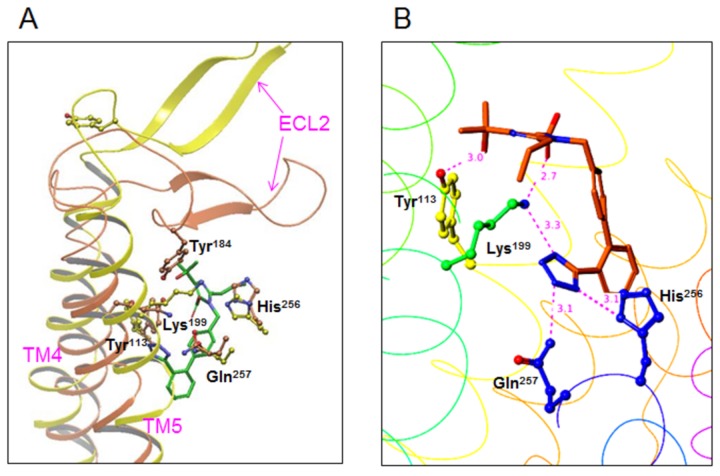
A. Position of the second extracellular loop (ECL2) in the model of AT1 receptor using bovine rhodopsin (orange) or CXCR4 (yellow) receptor as a template.B. Molecular modeling of the interaction between olmesartan and the AT1 receptor. The AT1 receptor is shown as a ribbon and Tyr113, Lys199, His256, Gln257 and olmesartan are shown as stick models. Color notation in the helix is as follows: transmembrane (TM)1, orange; TM3, yellow; TM5, dark green; TM6, blue; and TM7, purple.